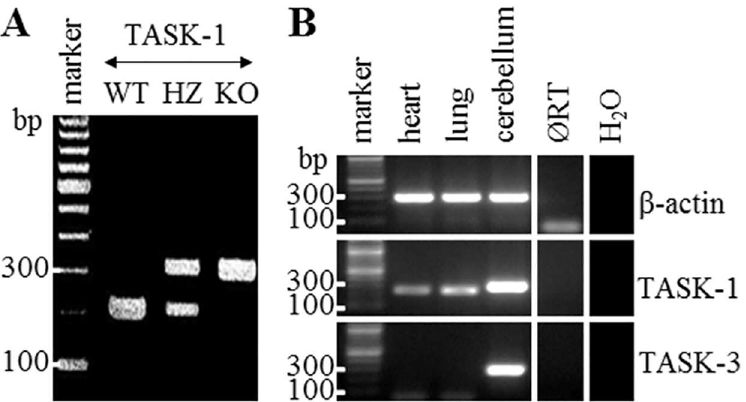
Fig 1. TASK-1 Knockout (KO) mice and expression of TASK-1 and TASK-3 mRNA in murine organs. (A) Genotype identification of TASK-1 wild-type(WT), heterozygous (HZ), and KO mice by PCR, agarosegel. (B) Expression of TASK-1 and TASK-3 mRNA in WT murineorgans, RT-PCR, agarosegel. Ø RT is lung sample processedwithout RT. β -Actin was used as internalcontrol. Heart served as positive control. H 2 O is control without cDNA